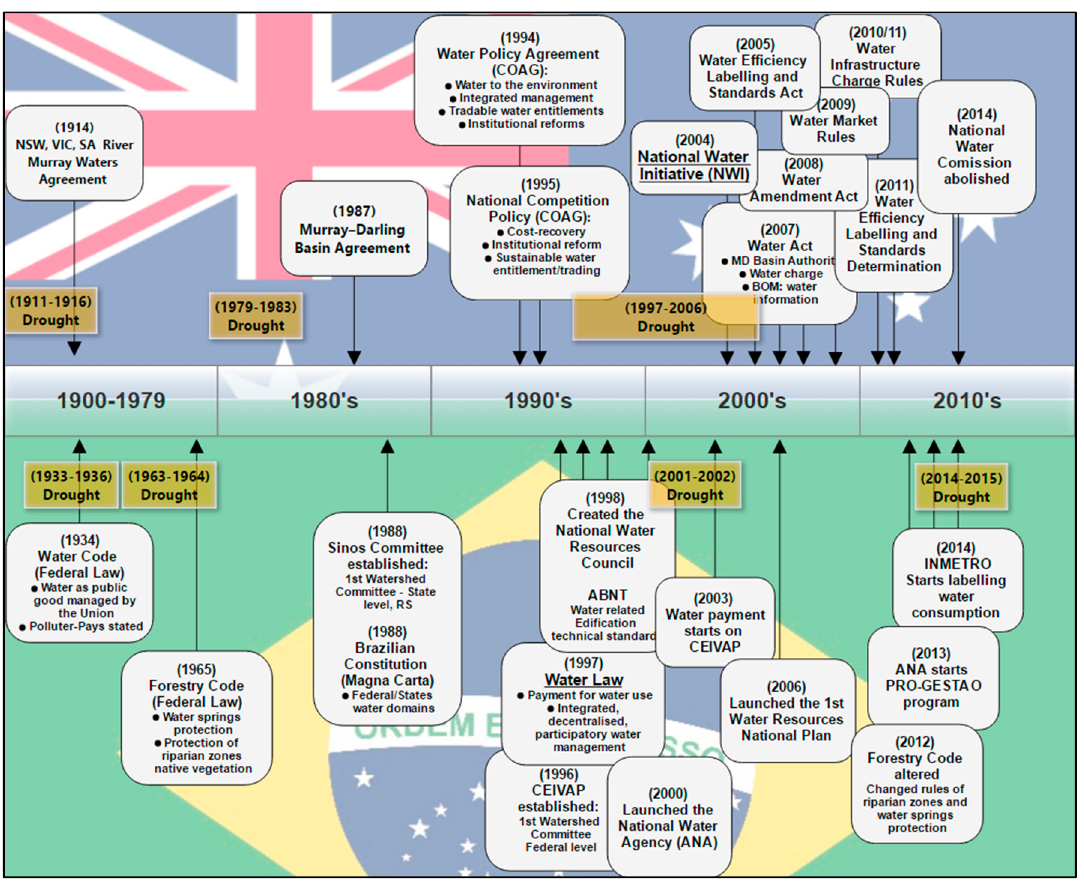
Figure 1. Timeline for water policies, programs, acts and initiatives: Australia and Brazil.